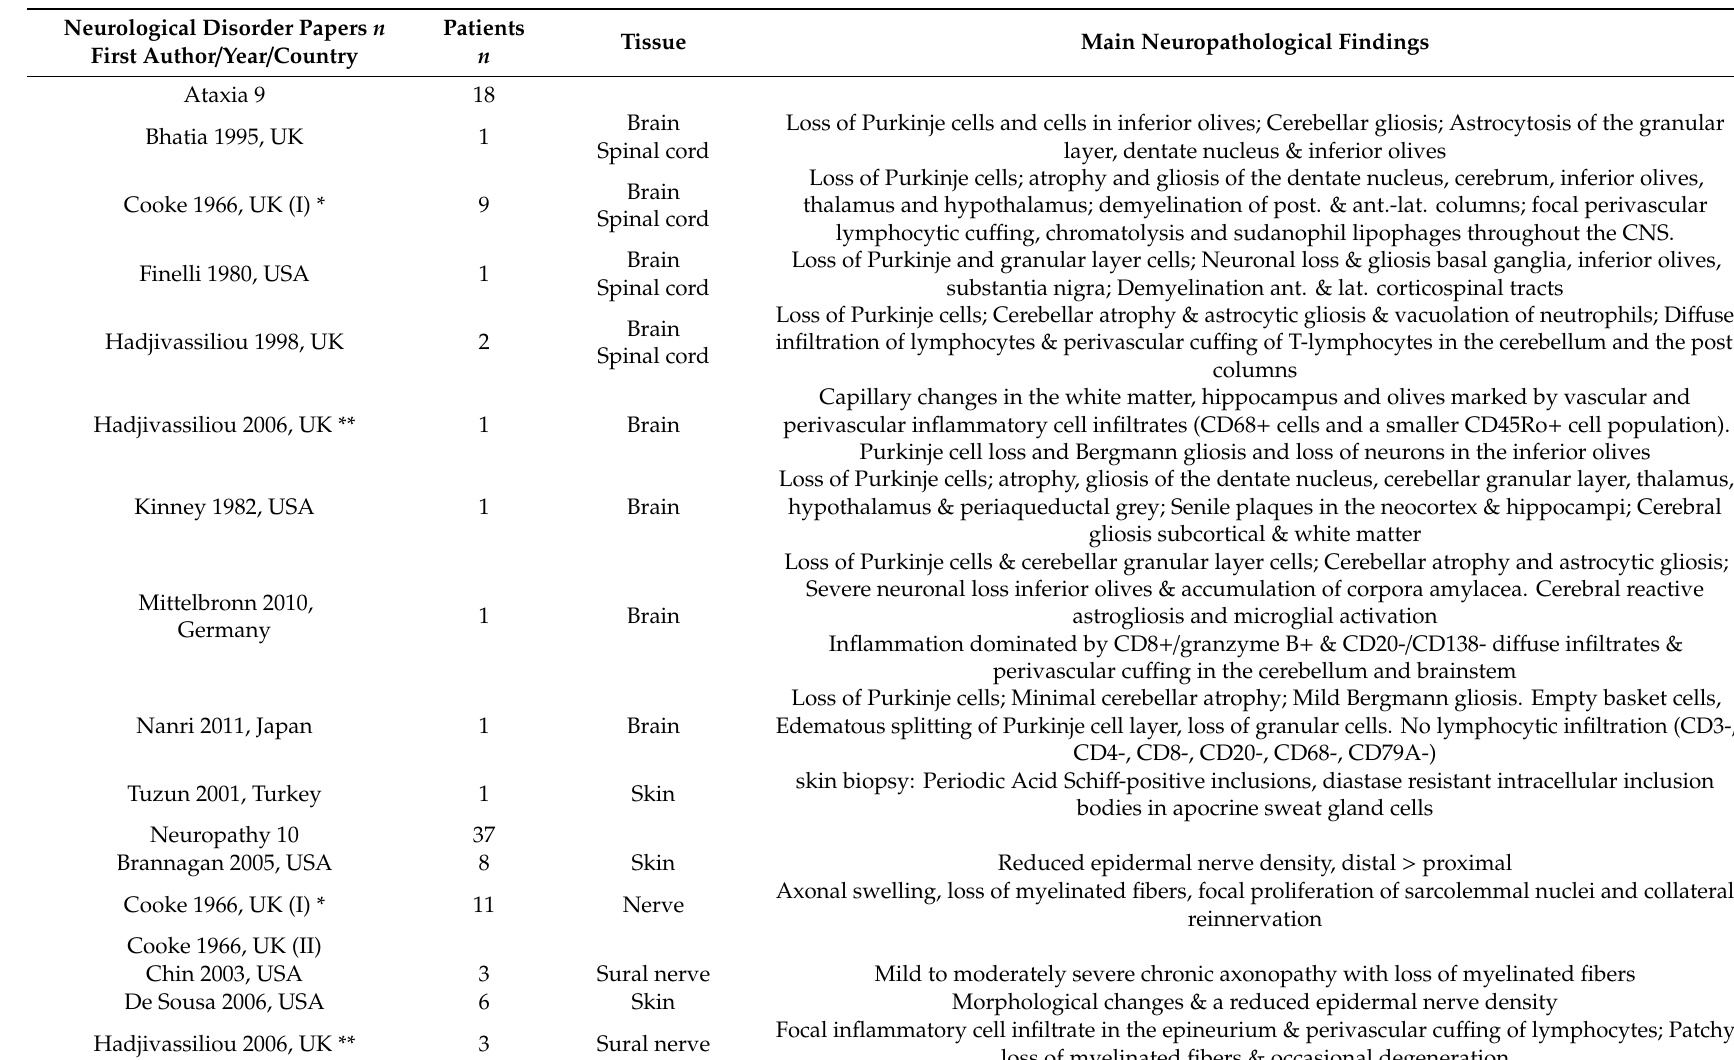
Table 1. Study characteristics and main neuropathological